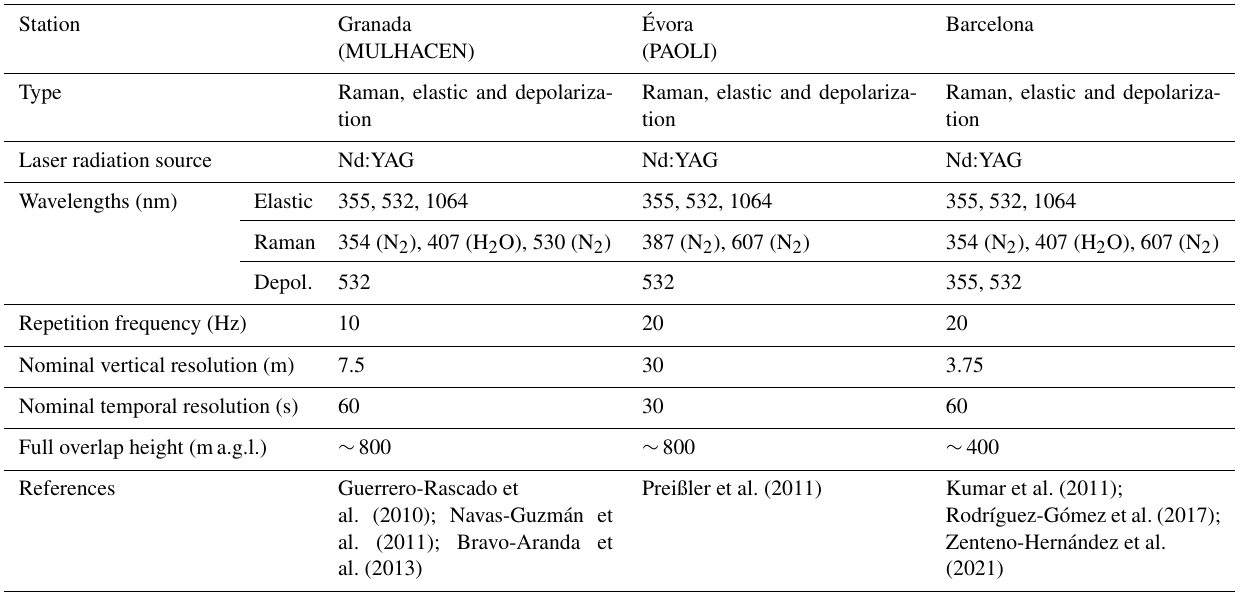
Table 1. Overview of the lidar systems of Granada, Évora and Barcelona stations.